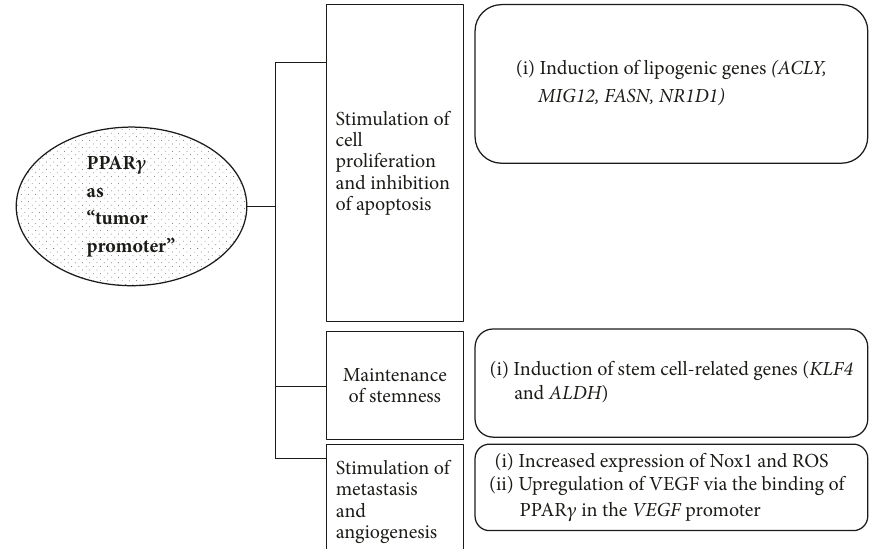
Figure 3: Action mechanisms of PPAR 𝛾 as a tumor promoter. ACLY, ATP citrate lyase; MIG12, midline-1-interacting G12-like protein; FASN, fatty acid synthase; NR1D1, Rev-ErbA 𝛼 ; KLF4, Kr¨uppel-Like Factor 4; ALDH, aldehyde dehydrogenase; Nox1, NADPH oxidase 1; ROS, reactive oxygen species; VEGF, vascular endothelial growth